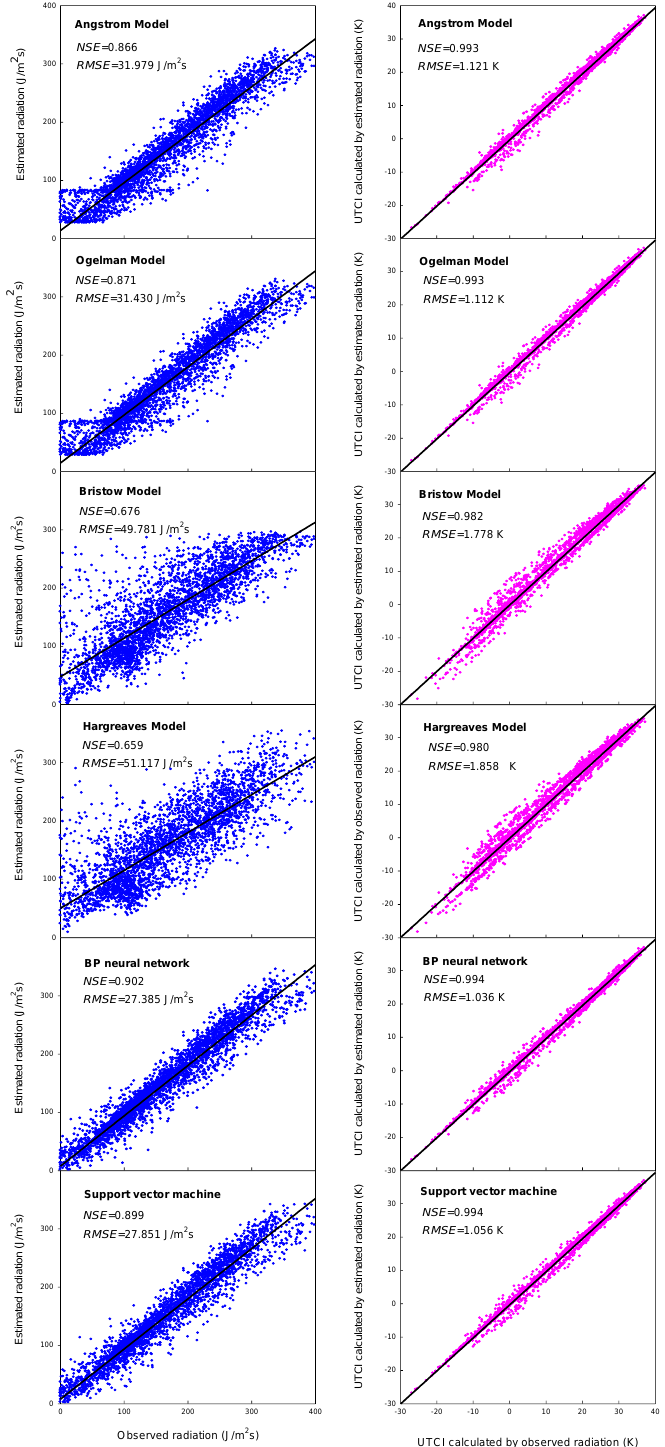
Figure 3. Validation of the radiation estimation and UTCI calculation in Beijing by different